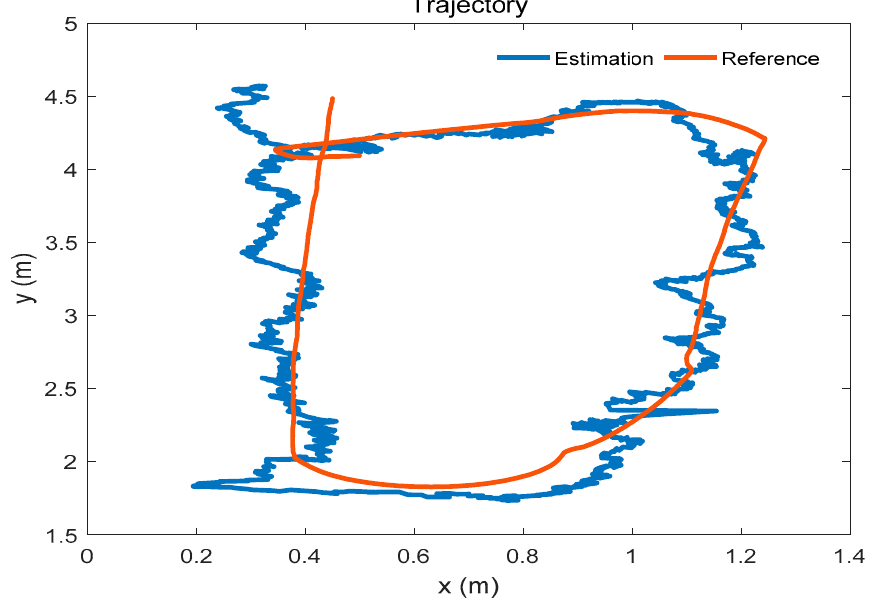
Figure 10. Positioning using the extended positioning system.